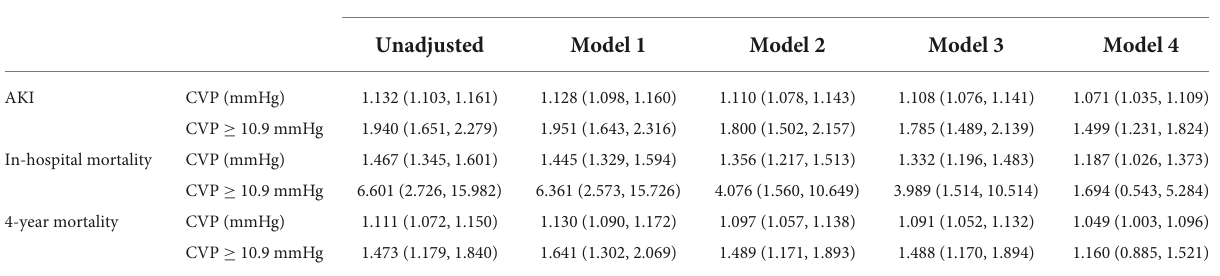
TABLE 3 Association of postoperative CVP with AKI and